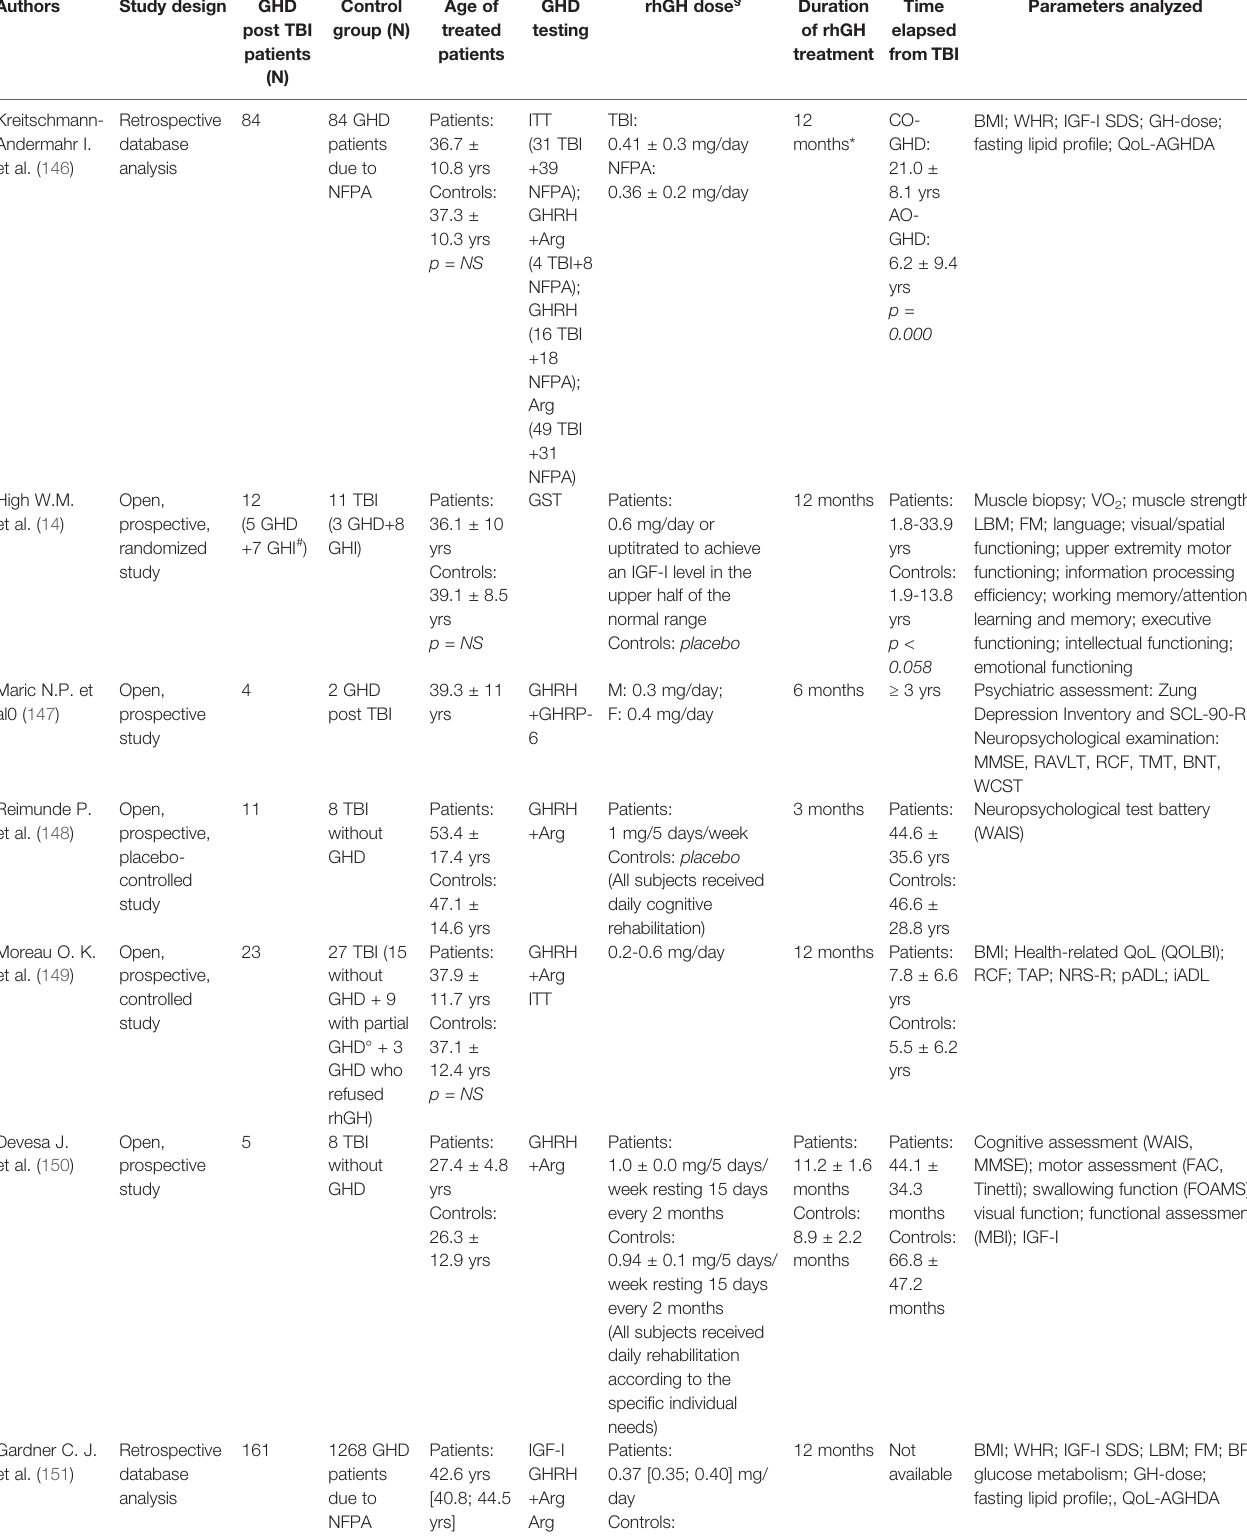
TABLE 2 | Studies investigating GH replacement therapy in adult post-TBI GHD